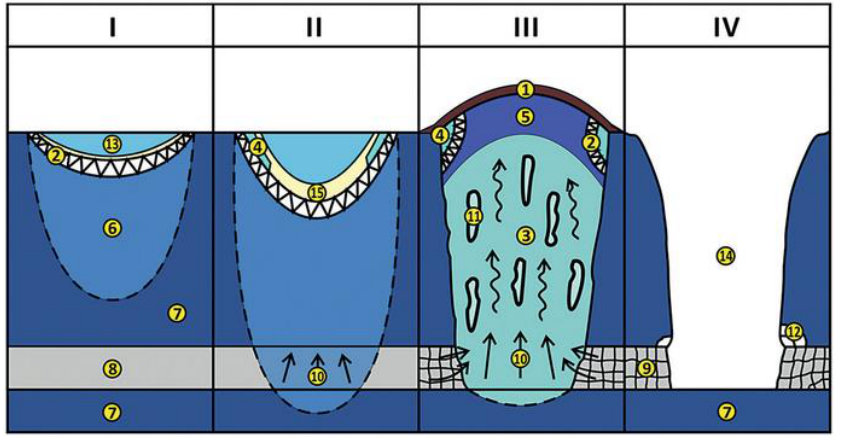
Figure 8. Stages of development of the Yamal crater (stages I, II, III, and IV). Legend: 1, cover horizon; 2, layer of ice between thawed and frozen soils; 3, frozen gas-saturated ice-bounded soil with traces of plastic deformations; 4, infiltration-segregating ice; 5, gastight roofing of permafrost; 6, zone of temperature increase in permafrost under the lake; 7, permafrost outside the heating effect of the lake; 8, layer of hydrate-containing permafrost; 9, zone of decompaction in the layer of hydrate-containing permafrost around the crater; 10, direction of the movement of fluids; 11, gas fluids; 12, caves and caverns in the lower part of the crater; 13, lake; 14, crater formed after the release of gas-saturated deposits; 15, talik.